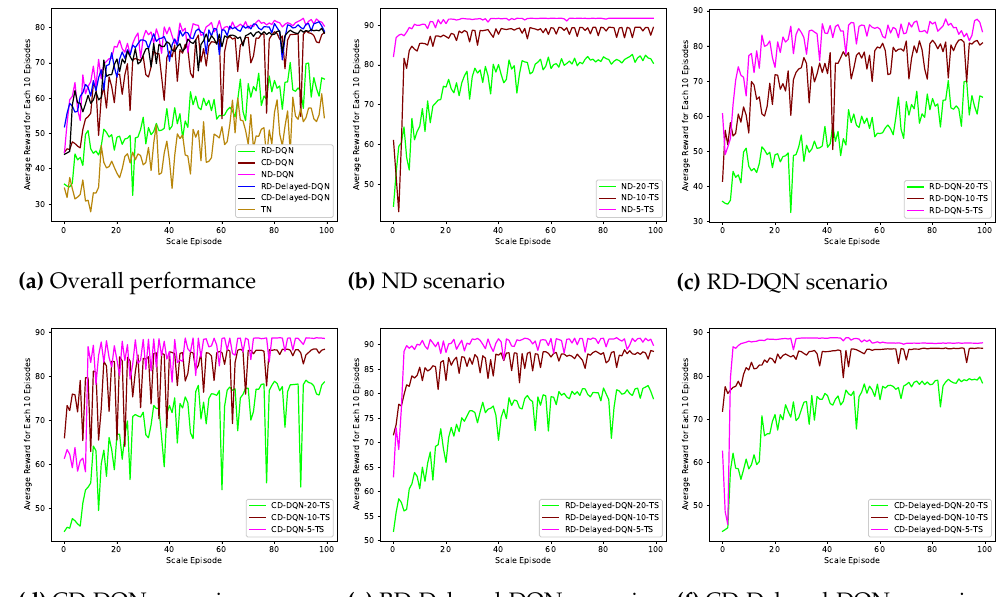
Figure 6. Evaluation results. “TN”, “ND”, “CD”, and “RD” mean turn-based, no-delay, constant- delay, and random-delay scenarios, respectively. “20-TS”, “10-TS”, and “5-TS” mean ∆ T is set to 20, 10, and 5, respectively. For example, “CD-DQN-5-TS” means a constant-delay scenario where states are collected every 5 time step and the agent adopts the DQN algorithm to make decisions. The results are the average rewards for each 10